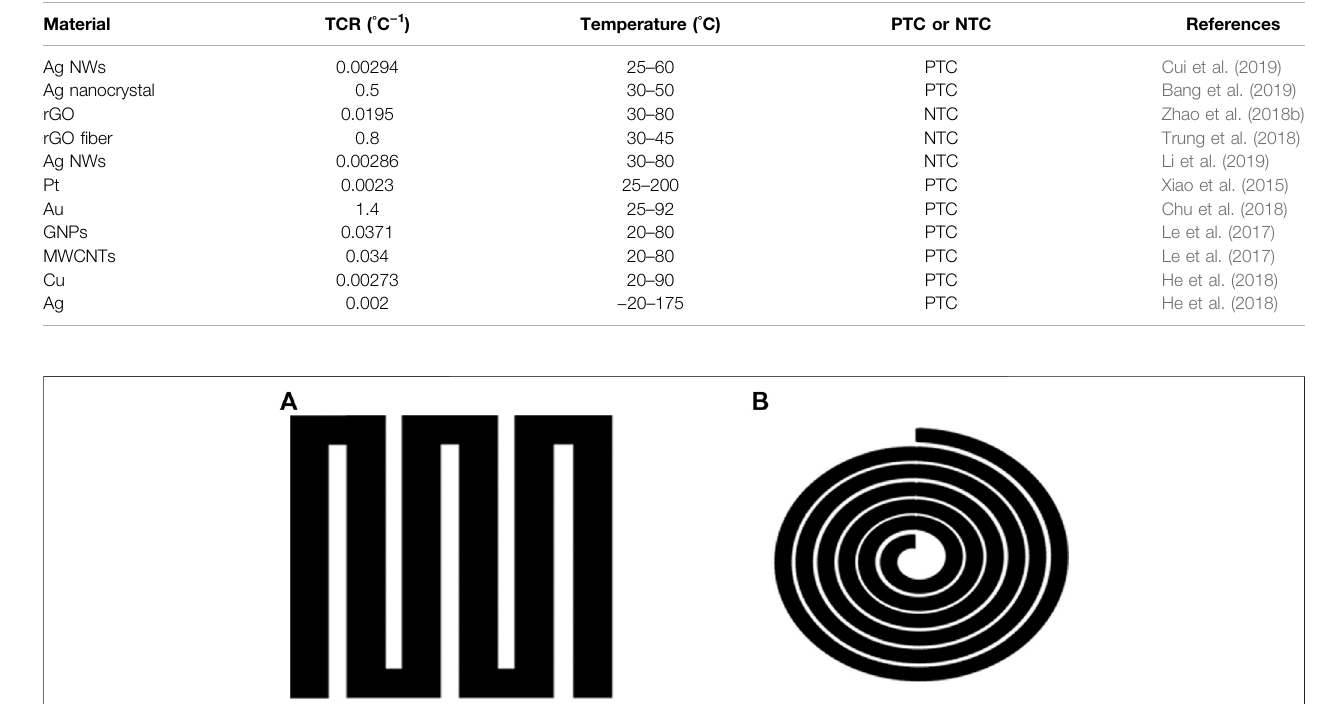
TABLE 2 | Comparison of different fl exible thermistors.